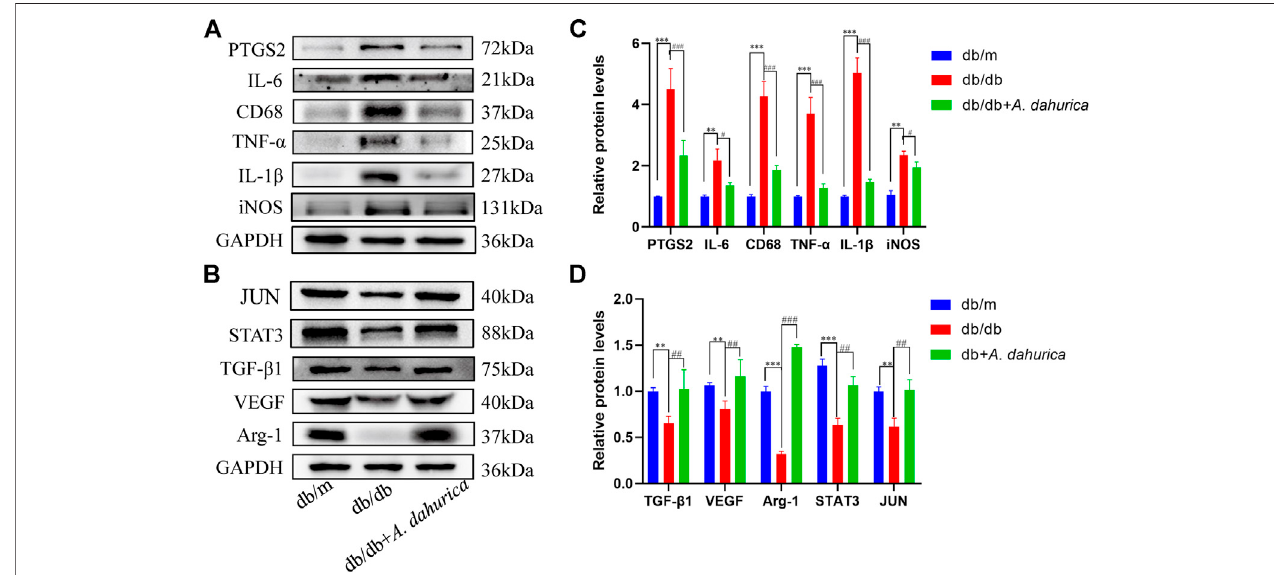
FIGURE 4 | (A) : Representative Western blot analysis of PTGS2 (72 kDa), IL-6 (21 kDa), CD68 (37 kDa), TNF- α (25 kDa), IL-1 β (27 kDa), and iNOS (131 kDa) in mice. (B) : Representative Western blot analysis of Arg-1 (37 kDa), VEGF (40 kDa), TGF- β 1 (75 kDa), STAT3 (88 kDa), and JUN (40 kDa) in mice. (C) : Densitometric results ofPTGS2, IL-6, CD68,TNF- α , IL-1 β and iNOS in mice as determined by Western blot. Error bars representSD. ** p < 0.01, *** p < 0.001, # p < 0.05, ### p < 0.001, *db/db vs. db/m group, # db/db + A. dahurica vs. db/db group, n (cid:2) 6 animals per group. (D) : Densitometric results of Arg-1, VEGF, TGF- β 1, STAT3, and JUN in miceasdeterminedbyWesternblot.ErrorbarsrepresentSD.** p < 0.01,*** p < 0.001, ## p < 0.01, ### p < 0.001,*db/dbvs.db/mgroup, # db/db +A.dahurica vs.db/db group, n (cid:2) 6 animals per